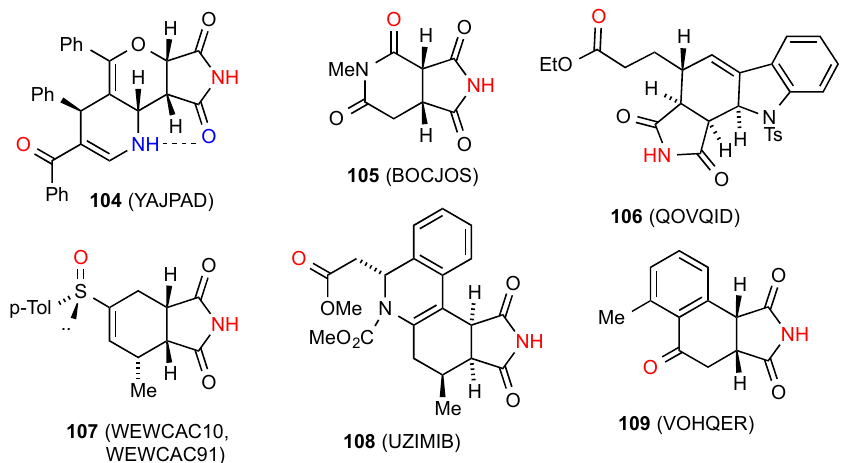
Figure 36. Six-membered ring-fused succinimides showing pattern F.